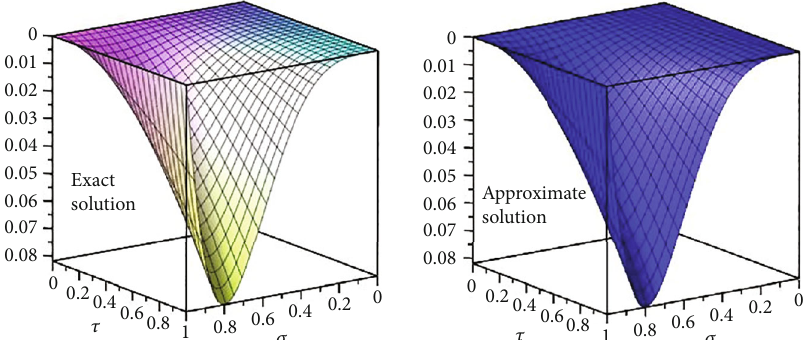
Figure 4: 3D plots of the exact and approximate solution for δ = 1 of Example 5.2.